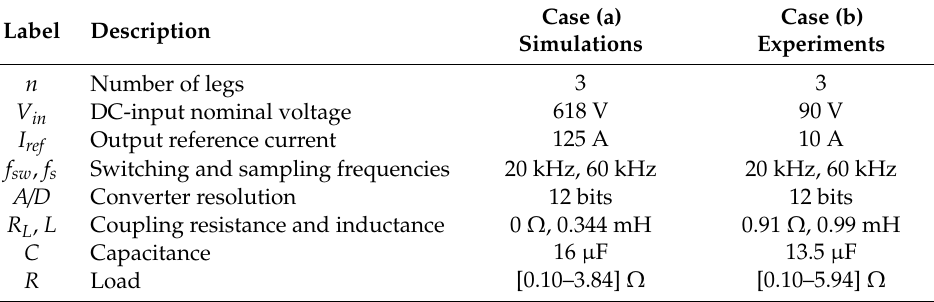
Table 1. Parameters of the